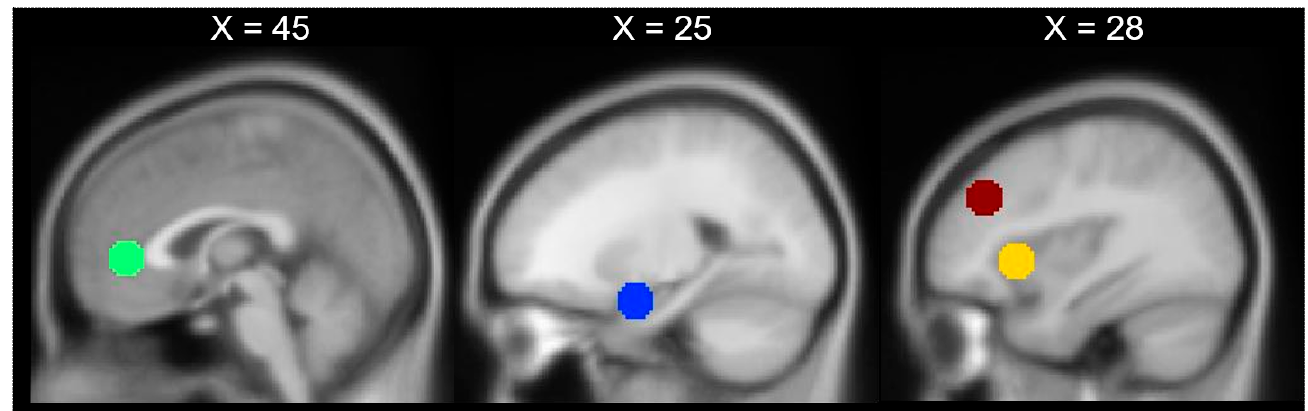
Figure 1. Region of interest (ROI) templates were spheres with a 10 mm diameter. Red = dorsolateral prefrontal cortex, yellow = anterior insula, green = pregenual anterior cingulate cortex, blue = amygdala.